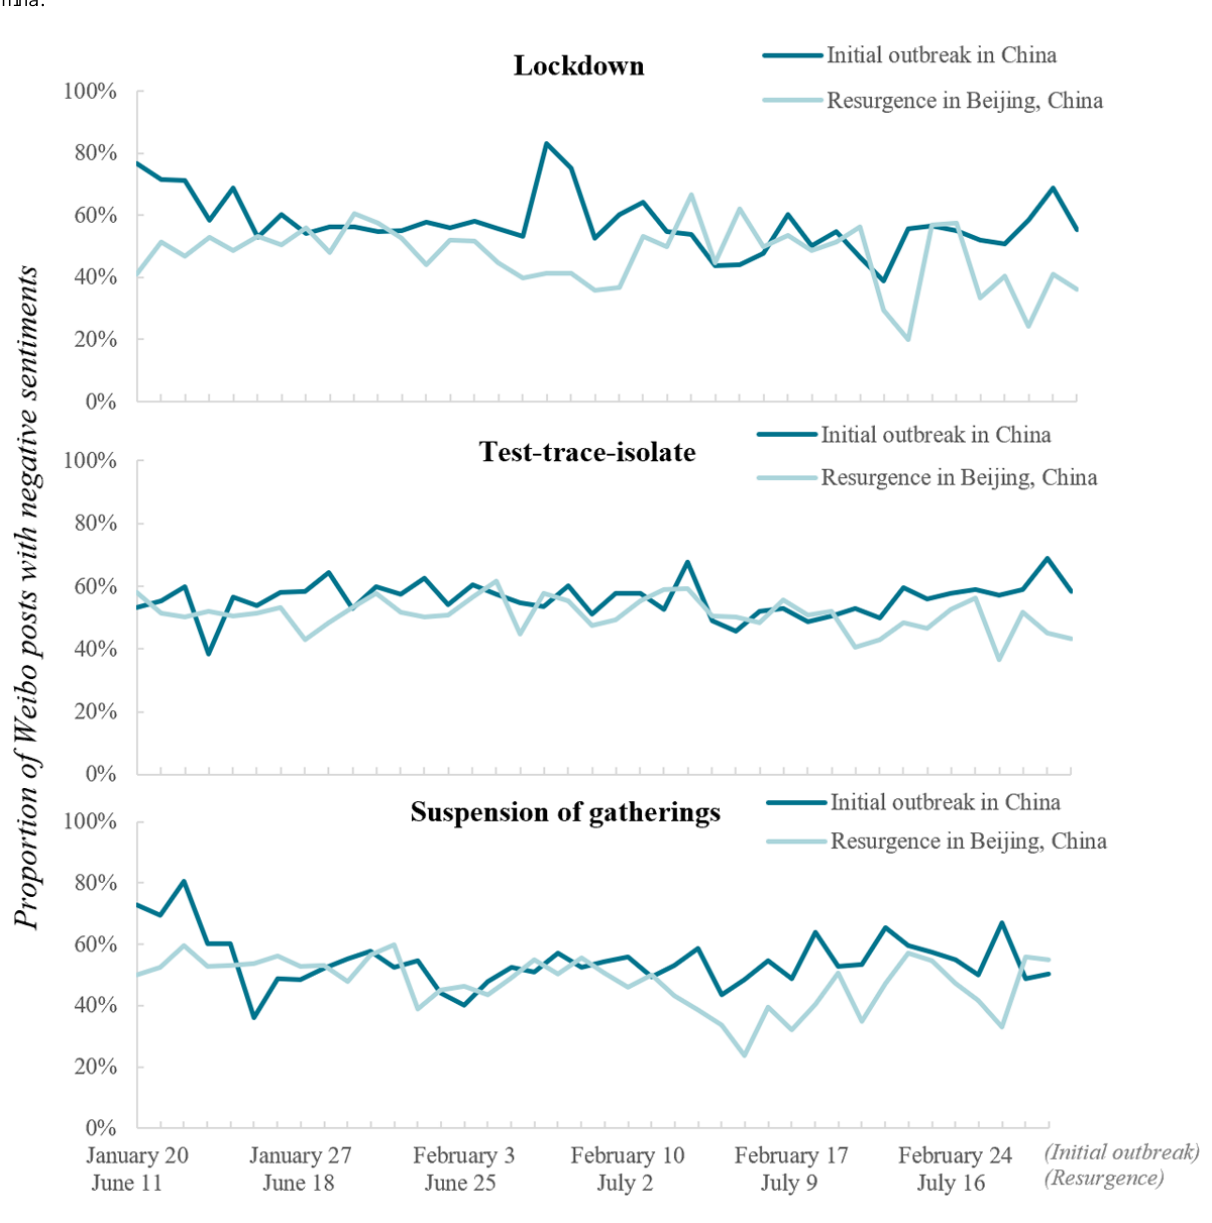
Figure 3. Proportion of Weibo posts with negative sentiments on containment measures during the initial outbreak and the resurgence of COVID-19 in